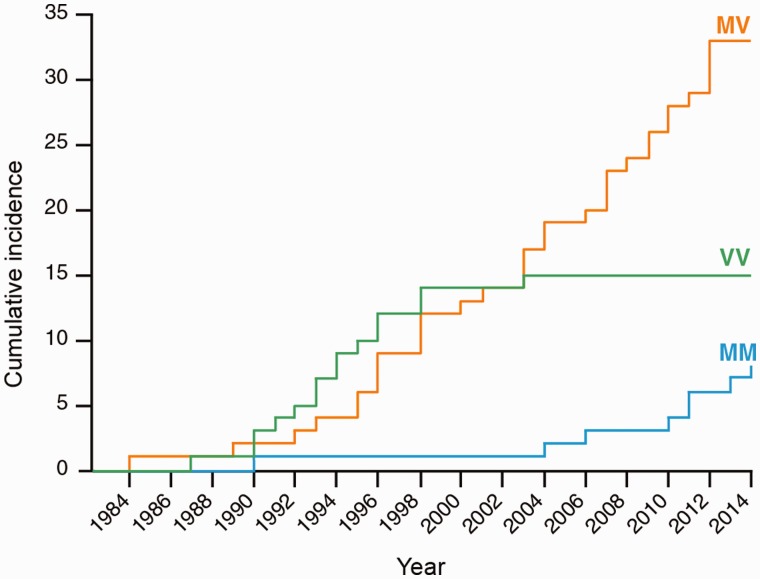
Cumulative incidence of patients stratified by PRNP codon 129 polymorphism. There is a highly significant difference in the distribution of the three polymorphisms at codon 129 over time and incubation period (ANOVA, P < 10−7), with each pairwise comparison of genotypes being statistically significant in post hoc analyses (P < 0.001) as indicated in the text.